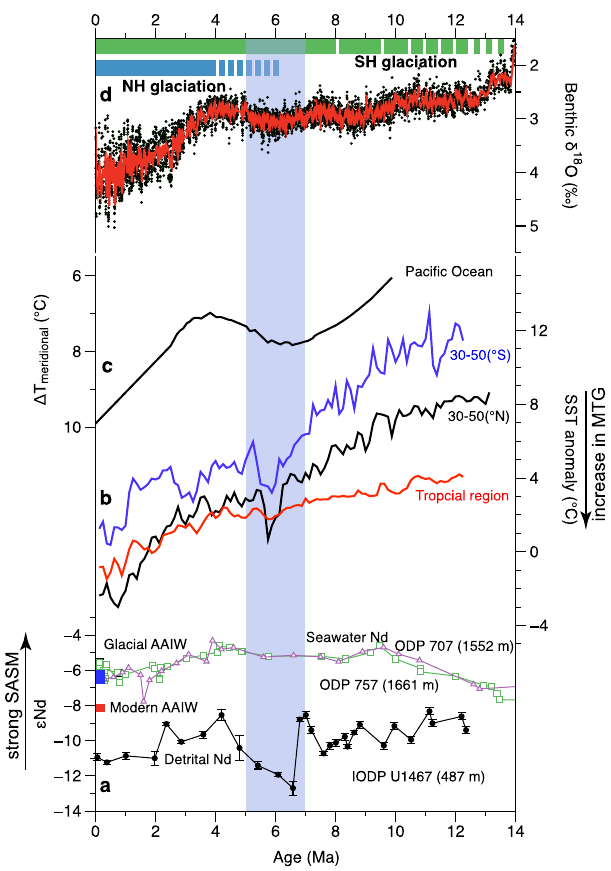
Fig. 4 | Comparisons of the South Asian summer monsoon (SASM) evolution with other climatic records. a Comparison of detrital ε Nd (2sigma S.D.) at Site U1467 with seawater ε Nd at ODP Sites 757 and 707 in the northern Indian Ocean 45 . The ε NdrangesoftheglacialandmodernAntarcticIntermediateWater(AAIW) 43,44 are indicated by blue and red rectangles. b Stacks of alkenone U k ’ 37 -based sea- surface temperature (SST) anomalies relative to today for subtropical (30 – 50° N, 30 – 50° S) and tropical regions 62 , with lower values indicating strong meridional temperature gradients (MTG). c Meridional temperature gradients of the Paci fi c calculated between sites from the northern subtropical and equator region 61 . d Benthic oxygen isotope record from ODP Site 1146 11 (21-point moving average) along with blue and green bars denoting the generally acceptedchronology of the SouthernandNorthernHemisphereCenozoicglaciation 60,64 – 67 .Theverticalshaded area represents the time interval of ~7 –